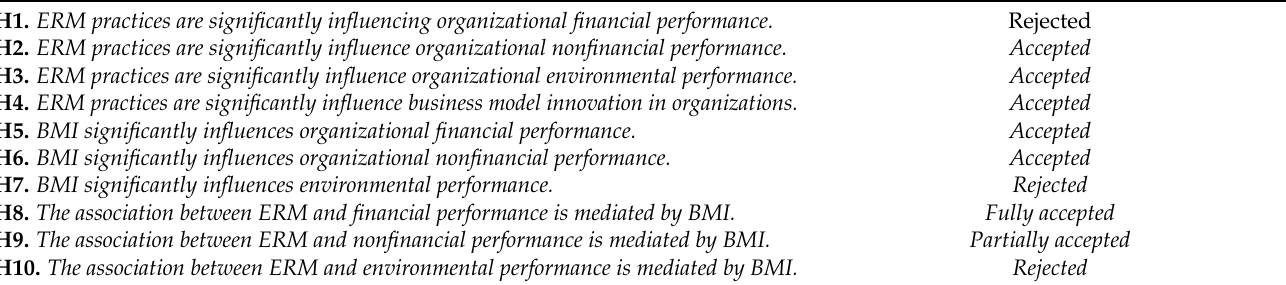
Table 6. Hypotheses